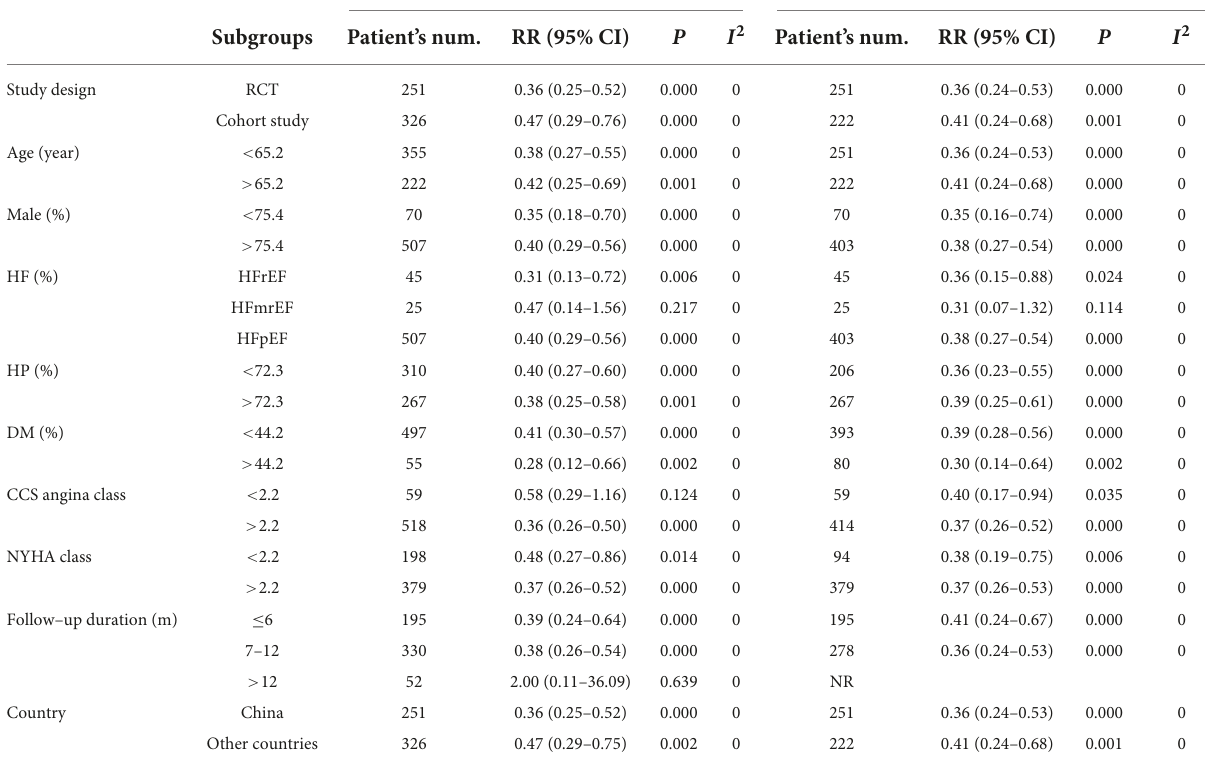
TABLE 3 Subgroup analyses for MACE and